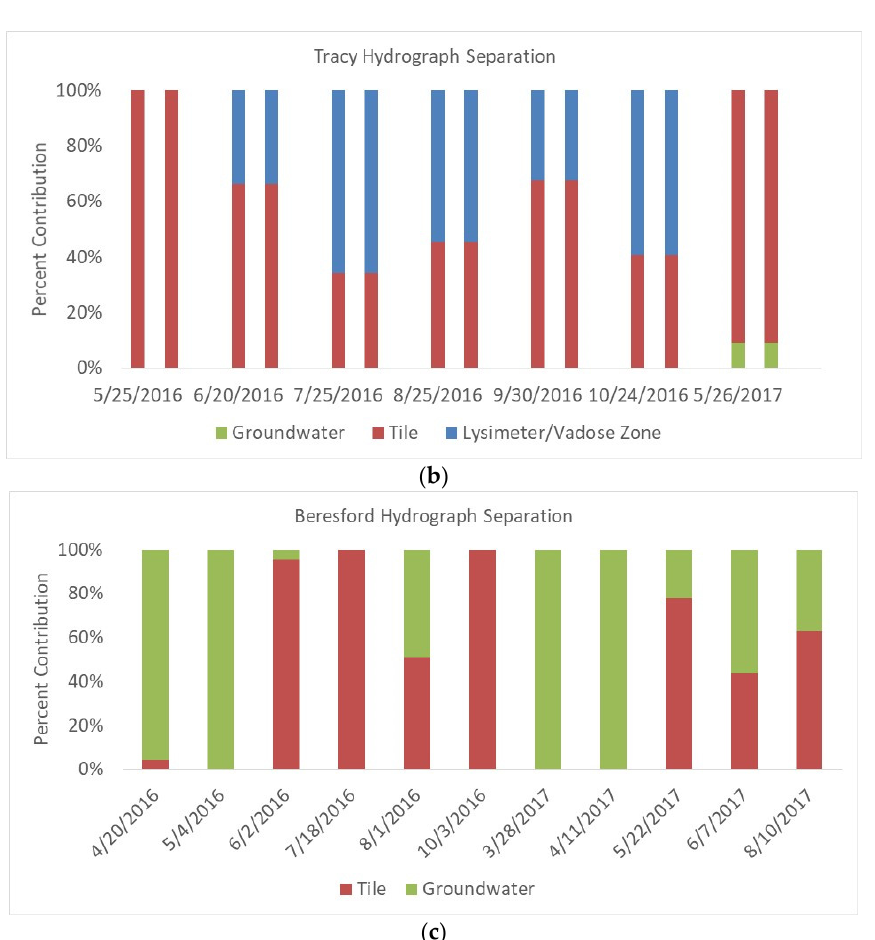
Figure 5. Two-component hydrograph separation for the three sites. GW stands for groundwater. The y-axis is the ratio of component assuming total volume is one. ( a ) Waseca site; ( b ) Tracy site; ( c ) Beresford